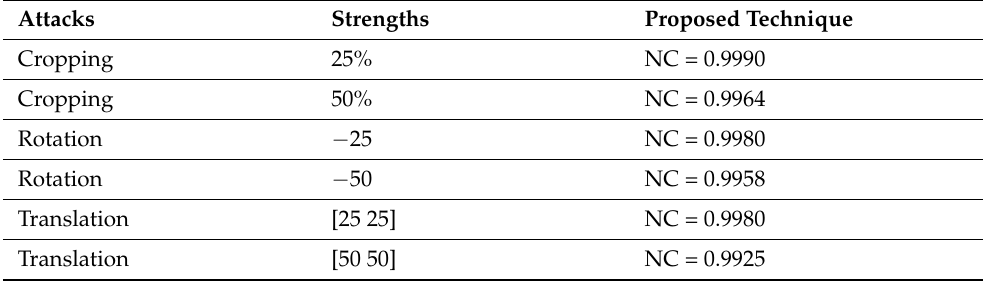
Table 5. Normalized correlation against geometric attacks.